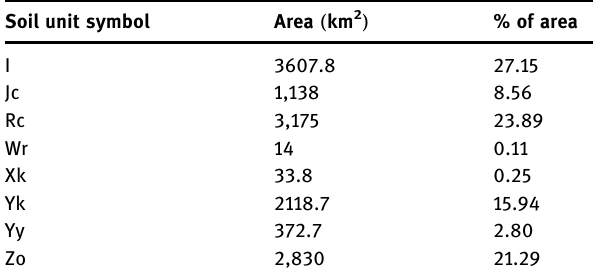
Table 3: Percntage area of each type of topsoil Soil unit symbol